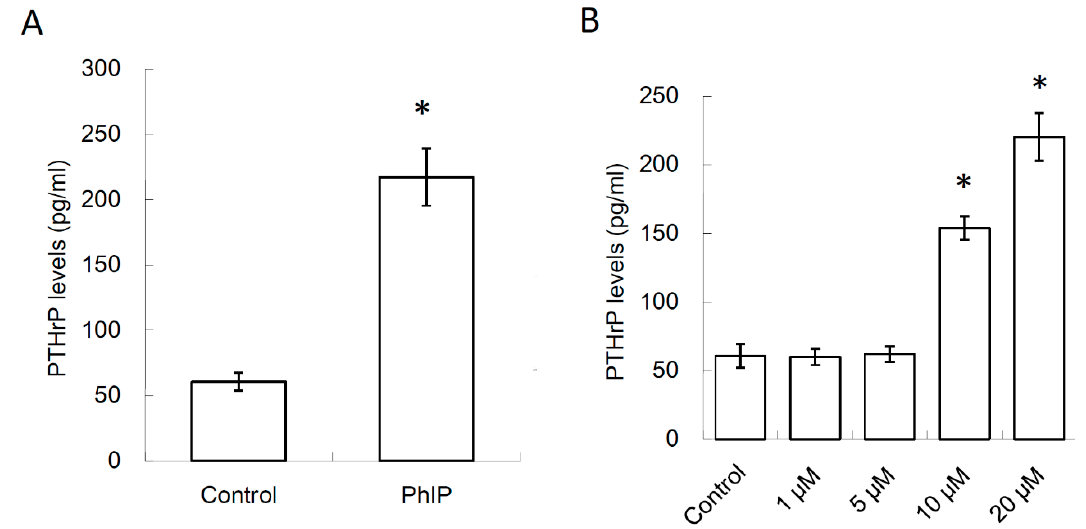
Figure 1. The effect of 2-Amino-1-methyl-6-phenylimidazo [4,5-b]pyridine (PhIP) on parathyroid hormone-related protein (PTHrP)-secreted renal cell carcinoma cell 786-O. The PTHrP levels in the condition medium (CM) of 786-O were detected by ELISA. ( A ) The PTHrP levels of 786-O CM after 20 µ M PhIP pre-treatment. ( B ) The PTHrP levels of 786-O cells after di ff erent dose of PhIP pre-treatment. Each value was the mean ± standard deviation (SD) of three independent experiments. * P < 0.05, significant difference between the control and test groups.